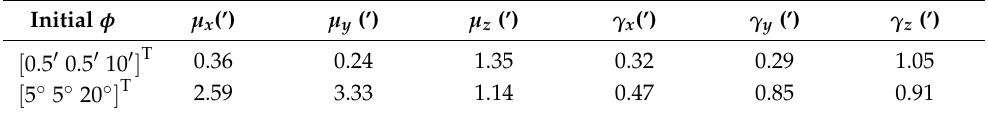
Table 6. RMSE values of µ and γ in the case of the large and small initial misalignment angles. Initial φ µ x